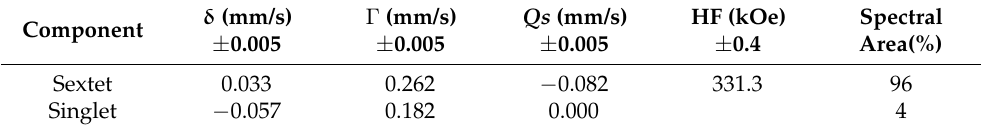
Table 8. Mössbauer parameters of the sintered Nd 2 Fe 14 B/Fe 90 Al 10 system for one hour at 300 ◦ C. Component